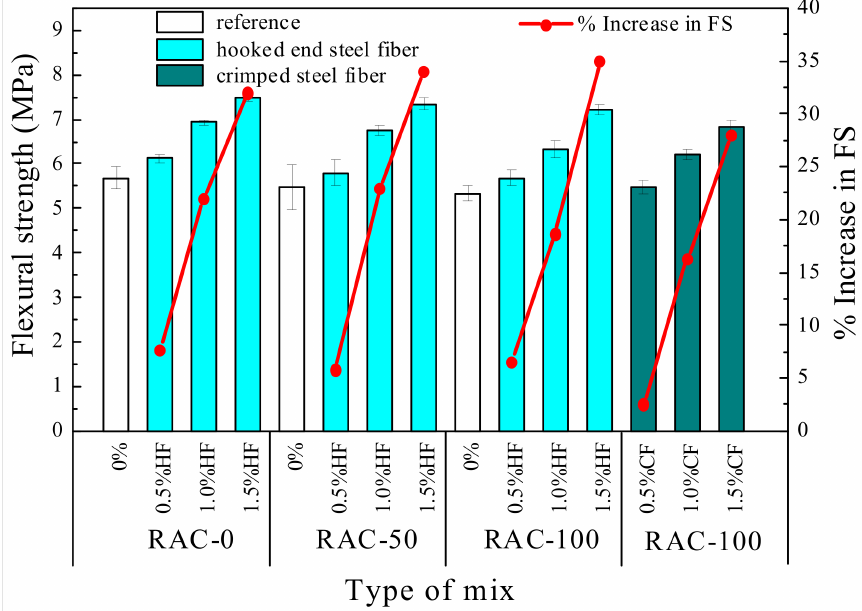
Figure 8. Flexural strength of fiber-reinforced RAC